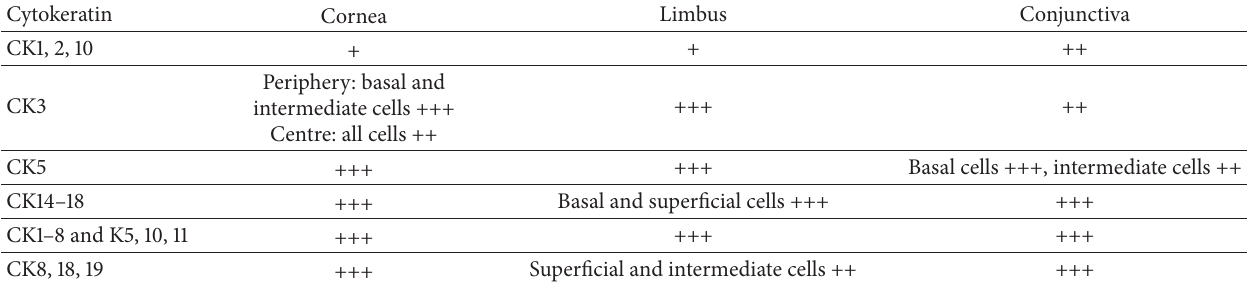
Table 1: A table showing the distribution of different keratins across the ocular surface epithelia (corneal, limbal, and conjunctival). Cytokeratin Cornea Limbus